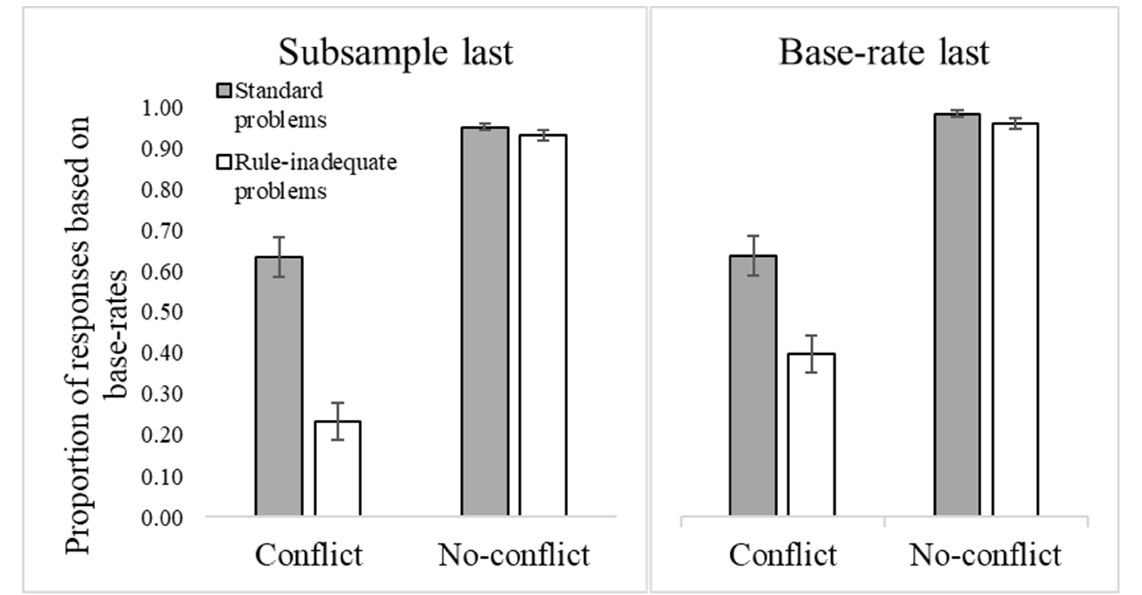
Figure 5. Proportion of correct responses to no-conflict problems and base-rate responses to the standard and rule-inadequate versions of conflict problems in both orders of information presentation (Experiment 3).